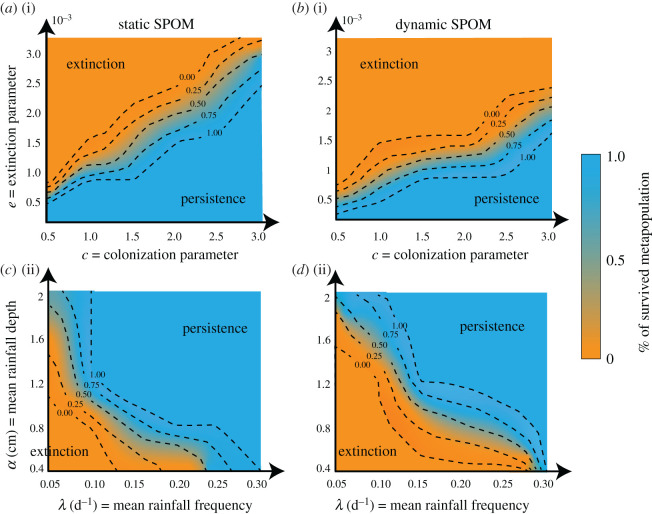
Sensitivity of static and dynamic SPOM simulations to changes in species traits (e, c) and hydrological variability (α, λ) on metapopulation persistence in N. Dakota (see electronic supplementary material, Information for the sensitivity analysis results obtained in Texas). (a) Results are shown for sensitivity to species traits, e [0.0001;0.0032] and c [0.5;3.0], with fixed ratio D/NND = 1.5, and hydroclimatic parameters (α = 0.90 cm, λ = 0.20 d−1 and ET = 0.50 cm/d). (b) Sensitivity of static and dynamic SPOM to hydroclimatic parameters α [0.40; 2.00] and λ [0.05;0.30], by fixing ET = 0.50 cm/d, e = 0.0008, c = 1.5 and D/NND = 1.5. For each set of parameter combinations, 100 Monte Carlo simulations were run.